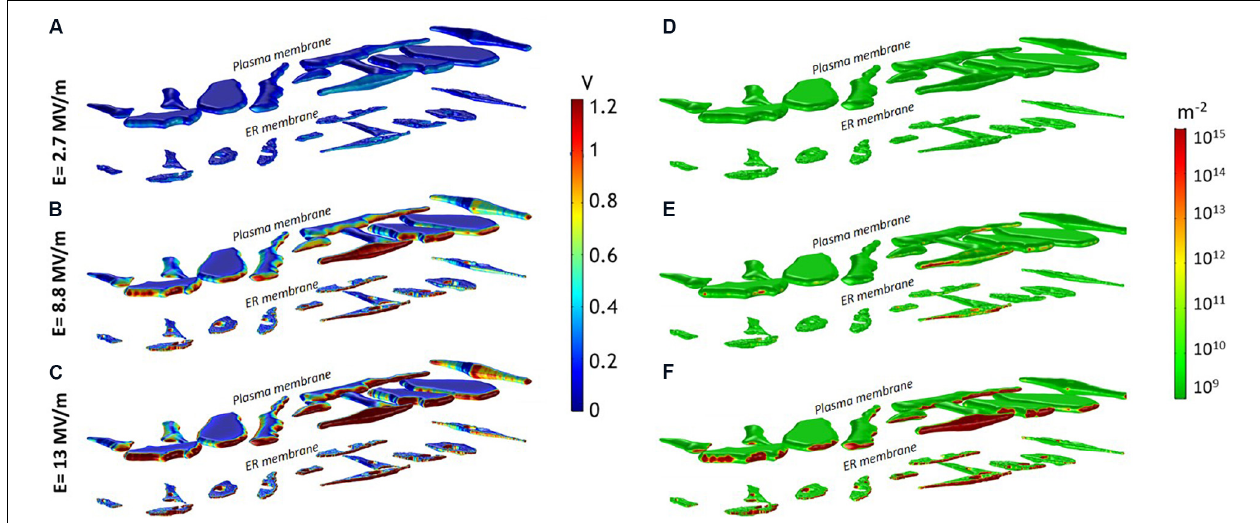
FIGURE 2 | (A–C) Induced TMP and (D–F) pore density spatial distribution on the entire investigated domain (12 cells) at 10 ns for an applied pulse amplitude of (A,D) 2.7 MV/m, (B,E) 8.8 MV/m, (C,F) 13